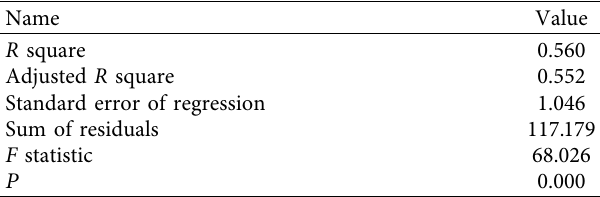
Figure 10: Velocity variation error-acceleration peak-discrimi- nation threshold relationship diagram. Table 1: Statistics of the linear model (acceleration peak involved).